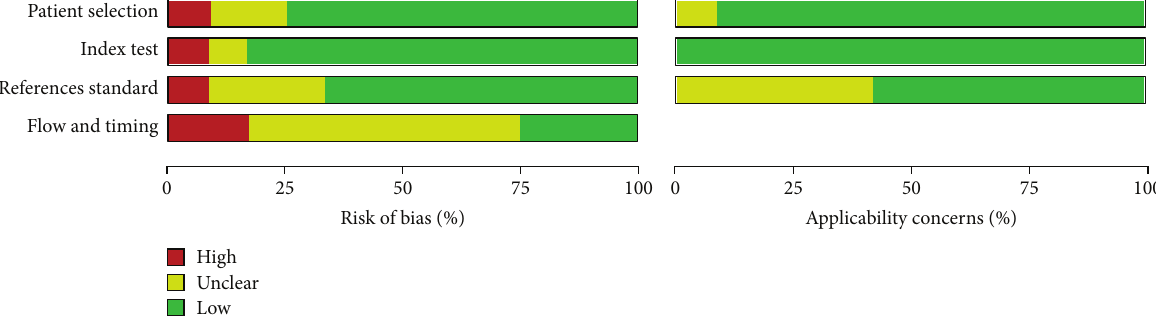
Figure 5: Risk of bias and applicability concerns summary: review of authors’ judgments about each domain for each included